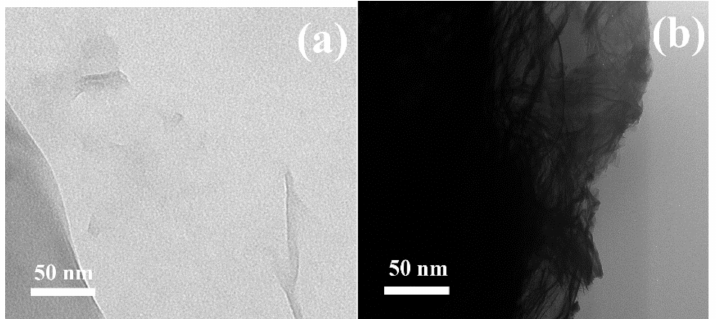
Figure 2. TEM images of ( a ) neat Graphene oxide (GO), ( b ) Graphene oxide grafted with poly(2-(trimethylsilyloxy)ethyl methacrylate)